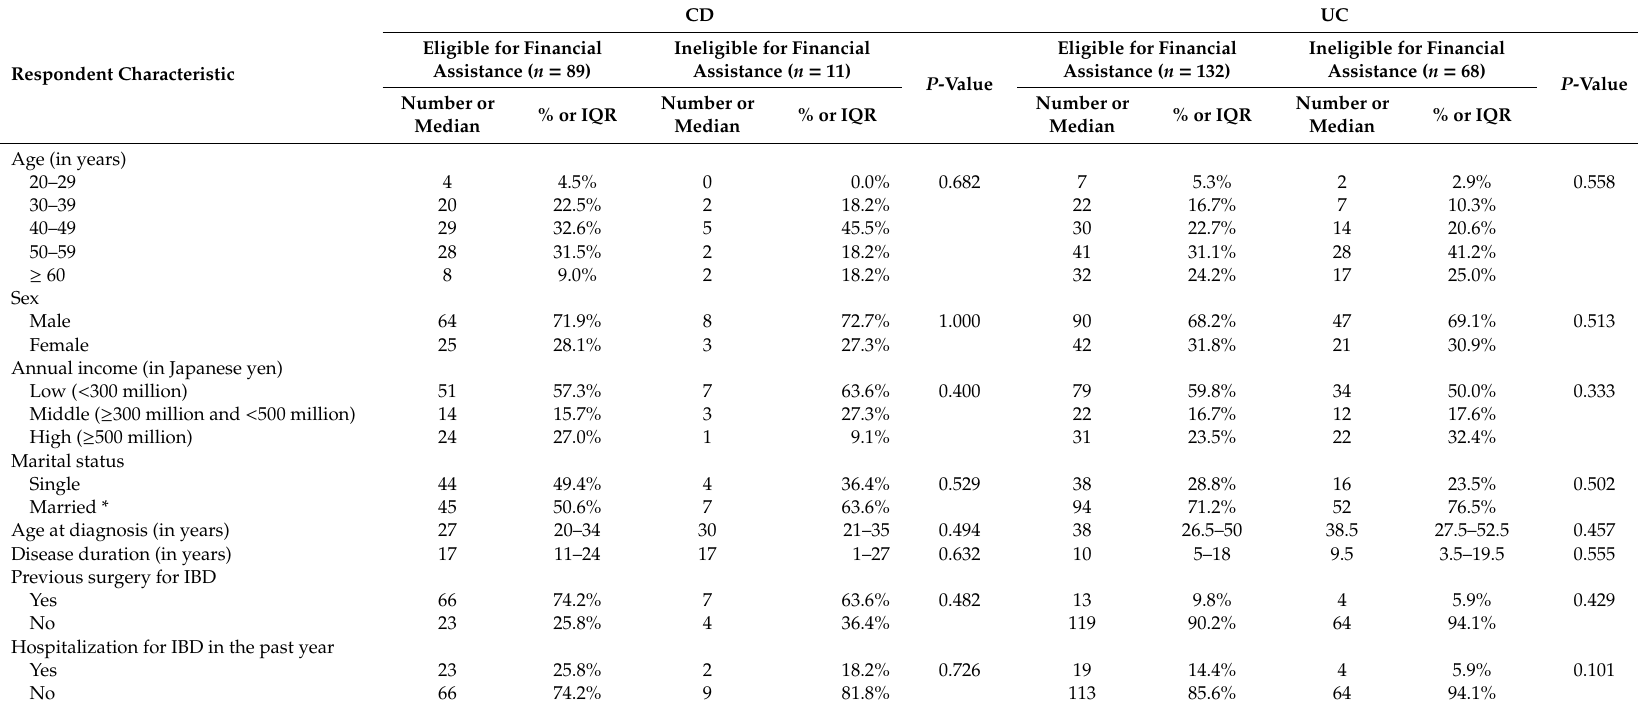
Table 1. Demographic characteristics and utility weight of survey